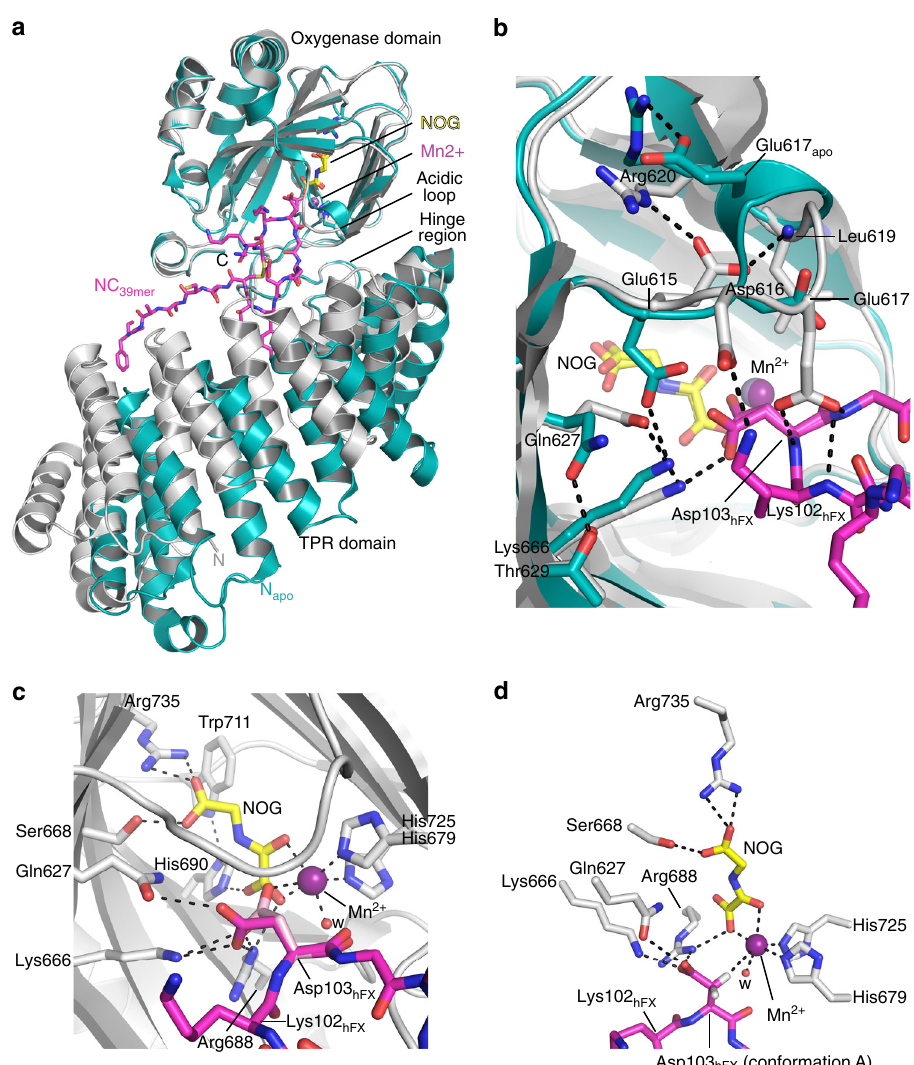
Fig. 4 Signi fi cant conformational changes occur in AspH upon substrate binding. Color code: grey: His 6 -AspH 315 – 758 (AspH-TPR-Ox:hFX); turquoise: His 6 - AspH 315 – 758 (AspH-TPR-Ox); magenta: carbon-backbone of NC 39mer peptide; yellow: carbon-backbone of N -oxalylglycine (NOG); violet: Mn; red: oxygen; blue: nitrogen; pale yellow: sulfur. w: water. a Superimposition of the AspH-TPR-Ox:hFX (grey) and AspH-TPR-Ox (turquoise) structures indicate conformational changes in the TPR domain, the hinge region, and the oxygenase acidic loop on substrate binding. b Superimposition of the AspH-active sites of the AspH-TPR-Ox:hFX (grey) and AspH-TPR-Ox (turquoise) structures: The interaction between Glu617 apo and Arg620 (2.5 Å) in the AspH-TPR- Ox structure is lost on substrate binding; both Asp616 and Glu617 interact with the substrate in the AspH-TPR-Ox:hFX structure. Gln627 (3.2 Å)